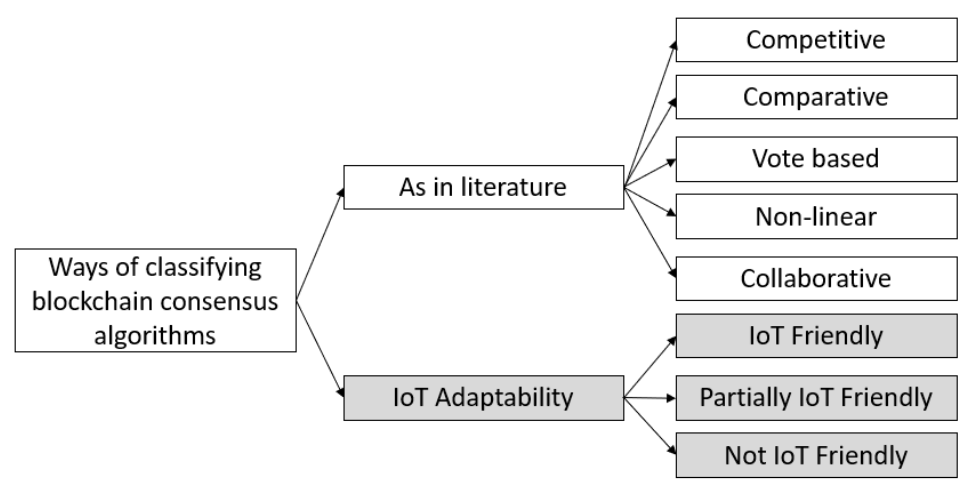
Figure 3. Proposed consensus